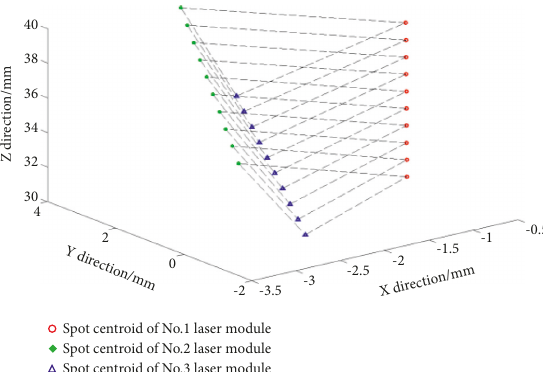
Figure 15: Calculated spatial coordinates of the last 10 sets of spot